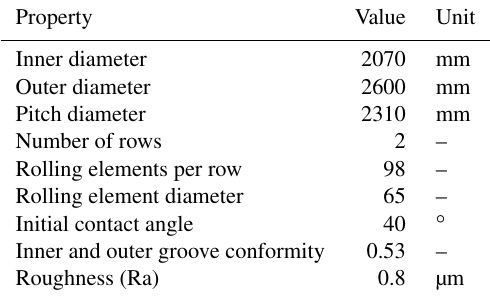
Table 2. Bearing